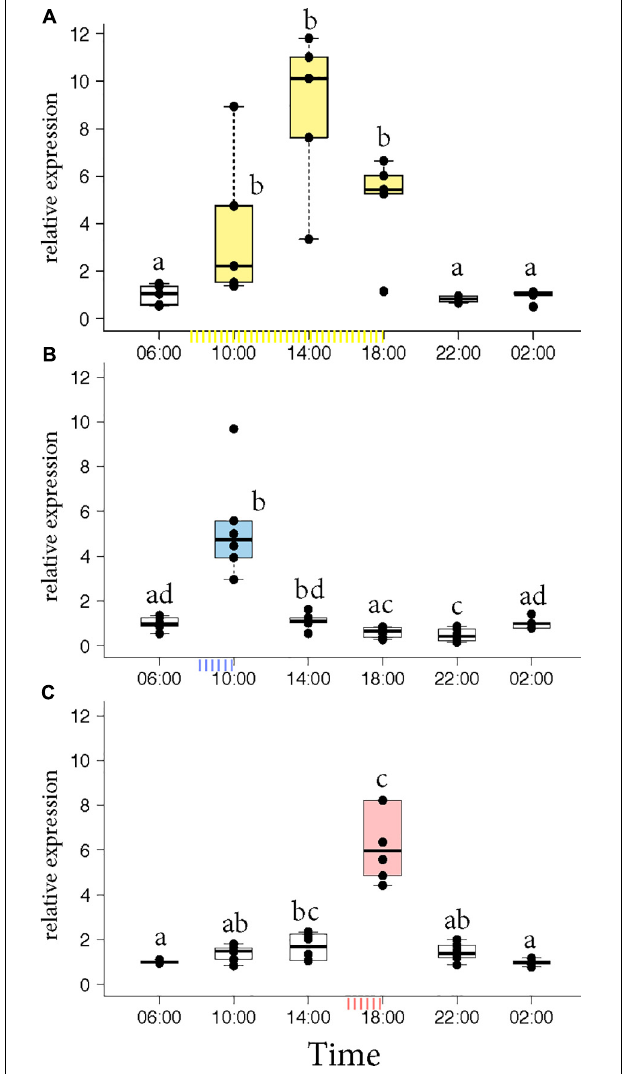
FIGURE 1 | Egr-1 expression in the absence of food reward. (A) Ad libitum (yellow) fed bees show elevated levels of Egr-1 all through the day, with a peak at 14:00. (B,C) Morning trained (blue) and evening trained (red) bees showed higher expression only at the trained time and significantly lower levels at all other time-points. Data shown as relative expression changes compared to 06:00 in the form of box-plots with individual data-points delineated, n = 6. KW-test with Dunn’s (“bh” method) multiple comparison was done on each experiment, p -values are shown in Supplementary Tables S1–S3,